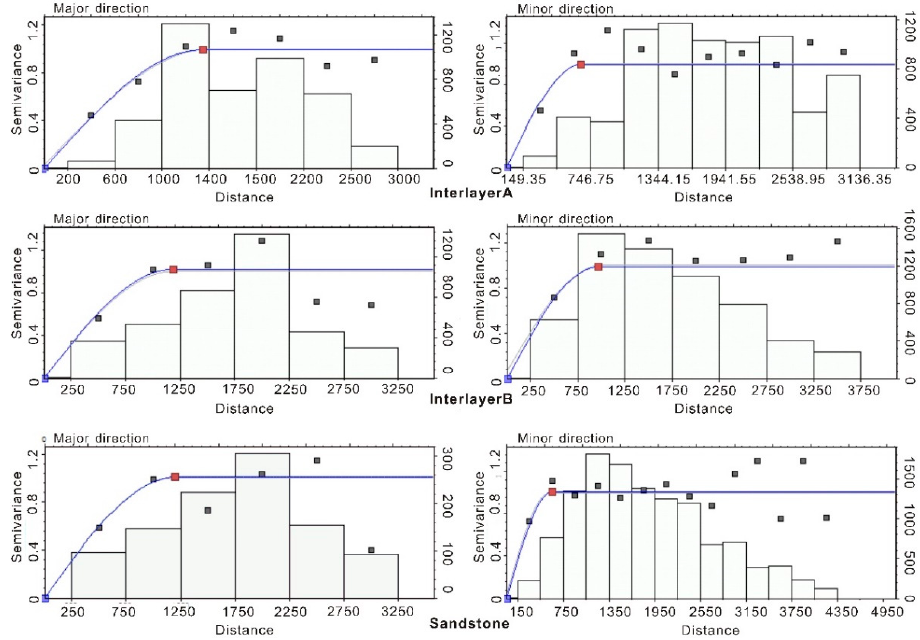
Figure 6. Variogram model fitting of sandstone and mudstone for layer H8S1 in zone B.